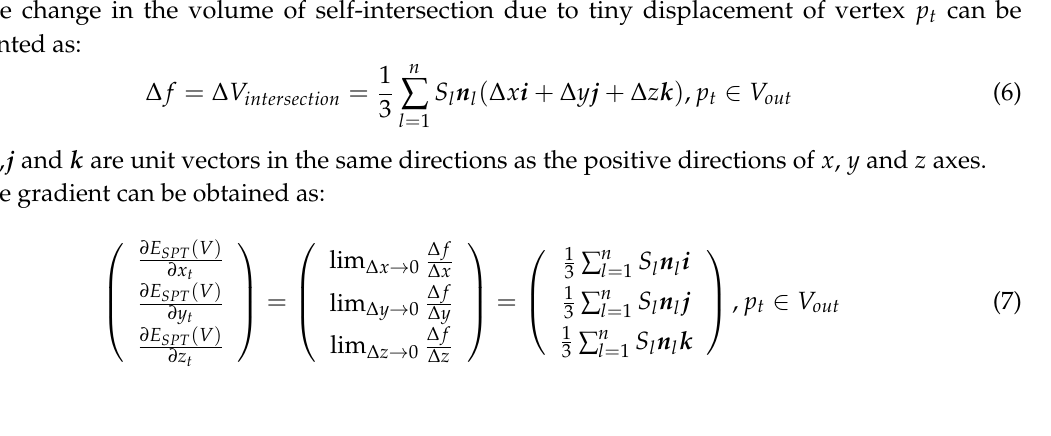
Figure 5. A tiny displacement on the vertex p t . The change in the volume of self-intersection is equal to the sum of volume of several neighboring